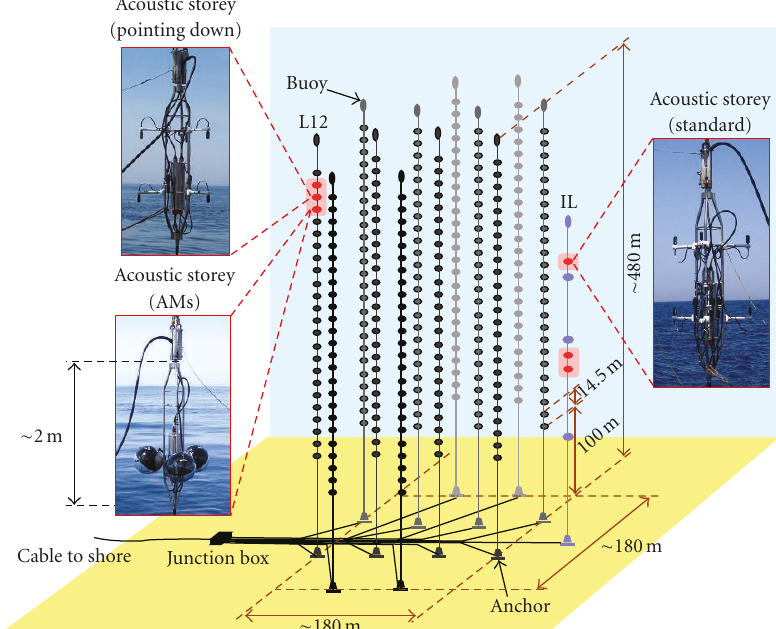
Figure 1: The ANTARES detector. The AMADEUS clusters are located on the Instrumentation Line (IL) and Line 12 (L12). Five clusters are equipped with hydrophones and one with acoustic modules (AM) using piezo ceramics glued to the inside of a glass sphere instead of hydrophones. Four of the hydrophone clusters were assembled with the hydrophones pointing upward, referred to as “standard”, while one cluster was assembled with the hydrophones looking